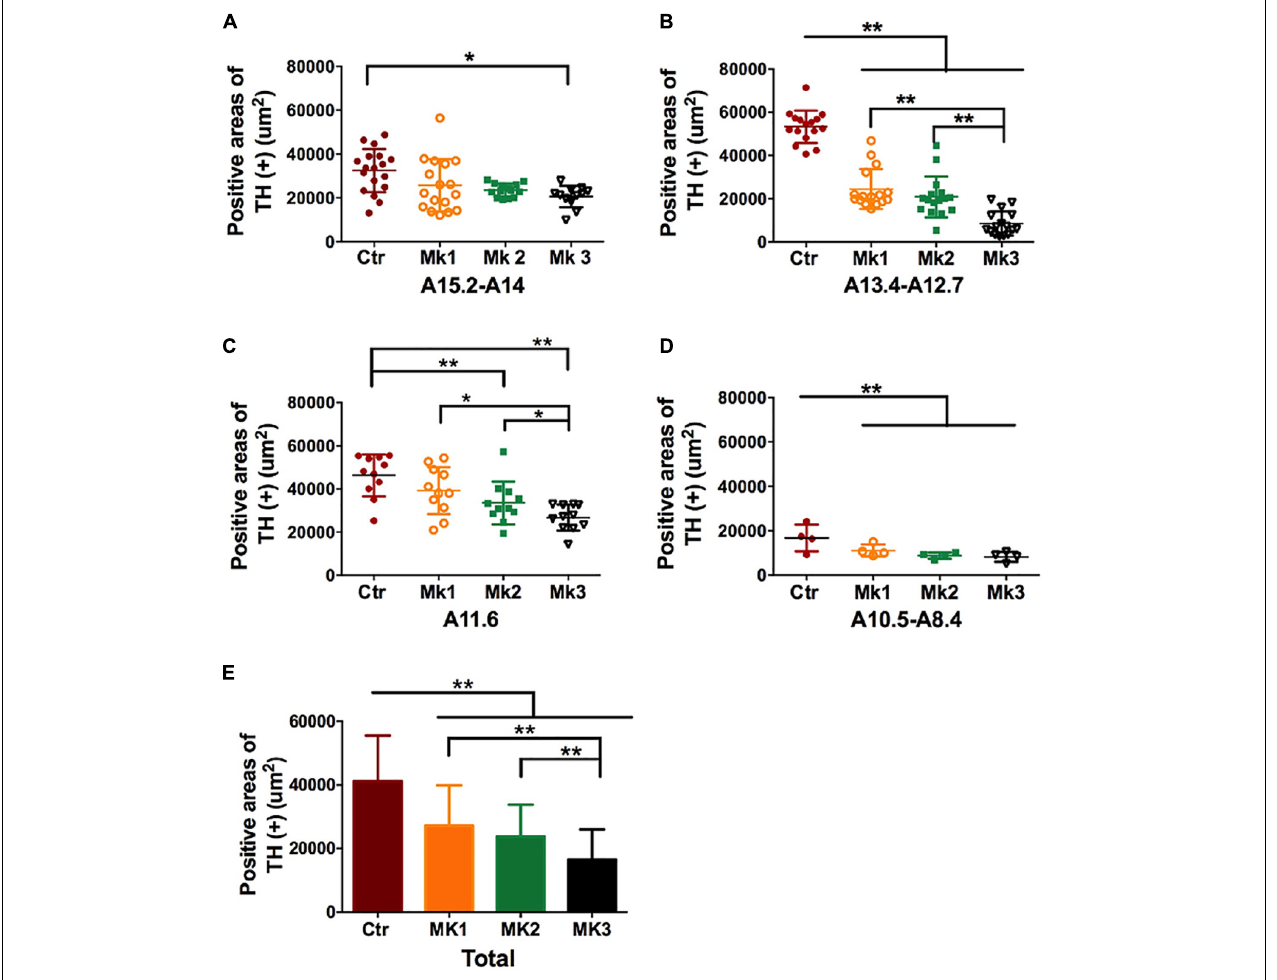
FIGURE 4 | Determination and comparison of TH staining in the SN in three MPTP-lesioned monkeys and in controlled monkeys. The data of TH (+) staining was collected, and stereology analysis was carried out in four SN tiers for each monkey, A15.2-A14 (A) , A13.4-A12.7 (B) , A11.6 (C) , and A10.5-A8.4 (D) Note that TH (+) staining was consistently lower in the Mk3 compared to controls in all tiers [ F (3,186) = 33.42, P < 0.0001]. In addition, TH (+) staining in Mk3 was also significantly lower than Mk1 and 2 in tier A13.4-A12.7 [ F (2,45) = 16.46, P < 0.0001] and A11.6 [ F (2,30) = 5.075, P = 0.0126]. (E) A comparison of TH (+) area in each monkey when the data were pooled together from all the SN tiers. Analysis showed that TH (+) positive areas in the SN of all three MPTP-lesioned monkeys were significantly reduced when compared to control [ F (3,279) = 43.5, P < 0.0001]. In addition, TH (+) areas in Mk3 were significantly lowered than that of Mk1 and Mk2[ F (2,133) = 11.14, P < 0.0001]. ANOVA, ∗ P < 0.05, ∗∗ P <